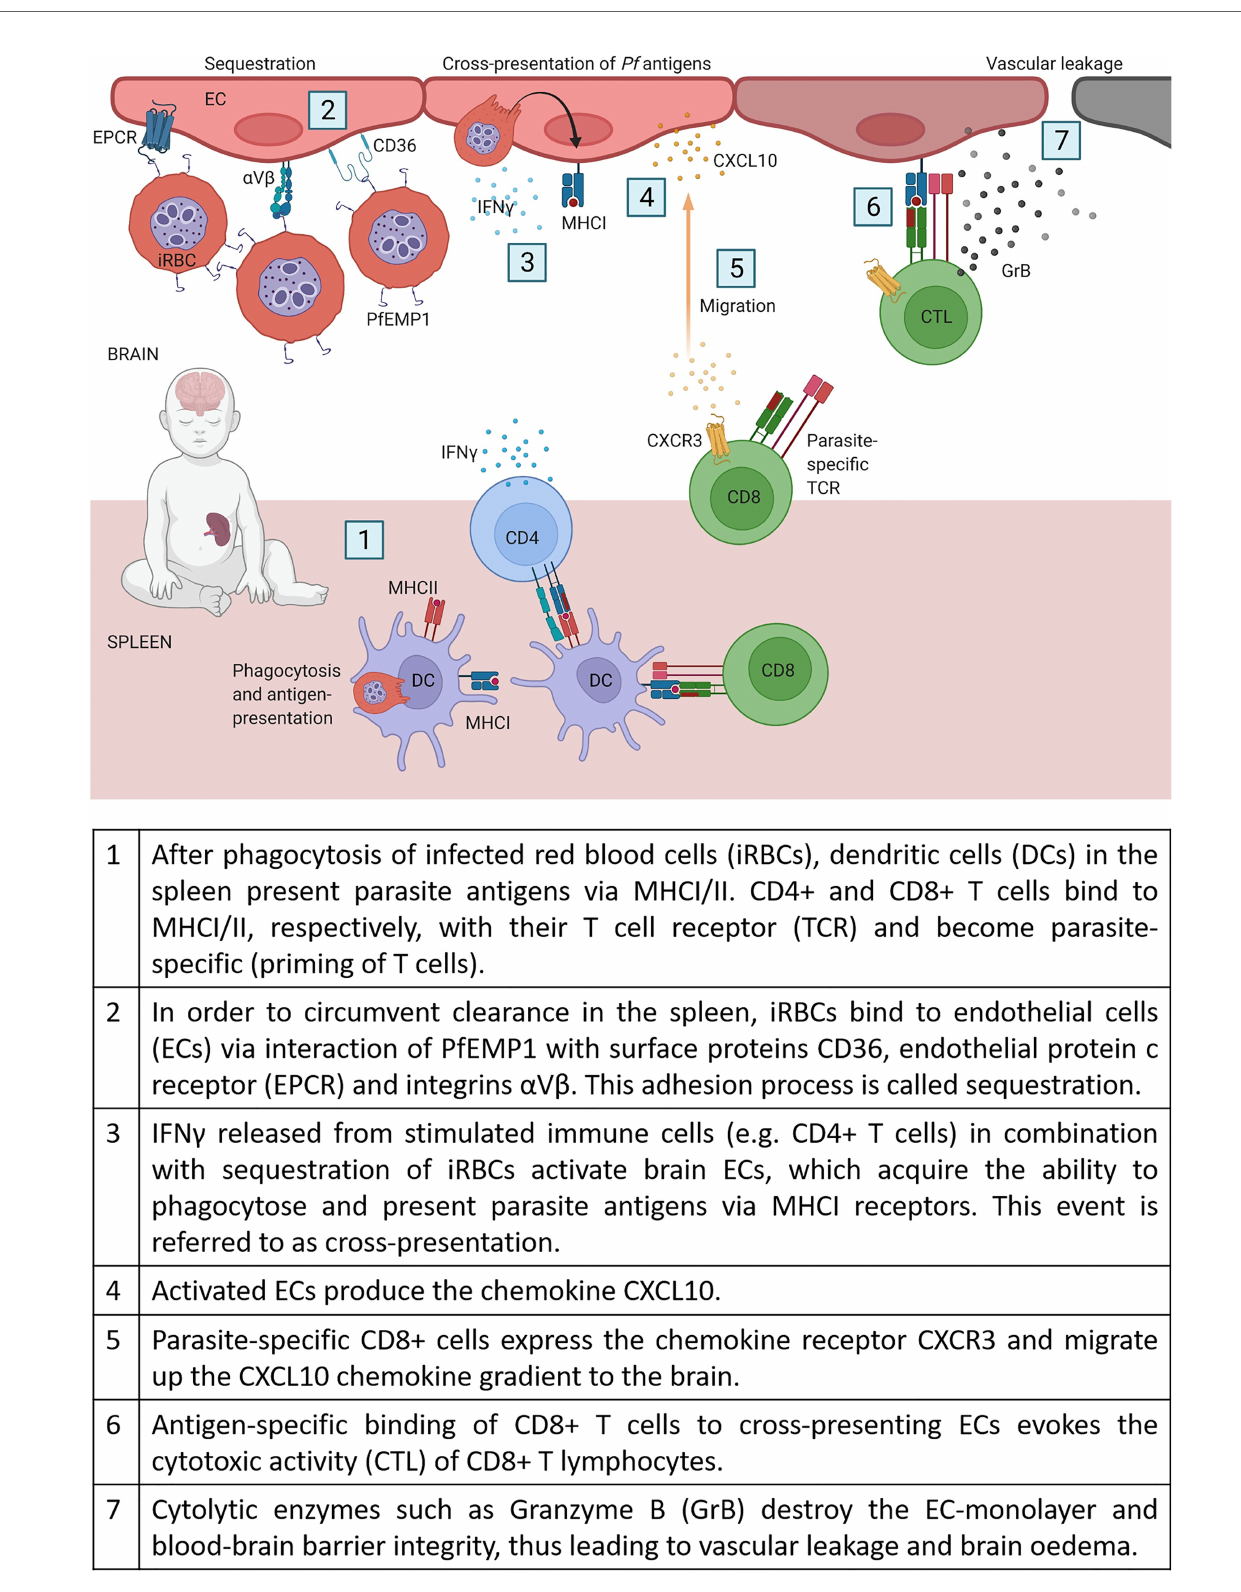
FIGURE 1 | CD8+ T cell dependent CM